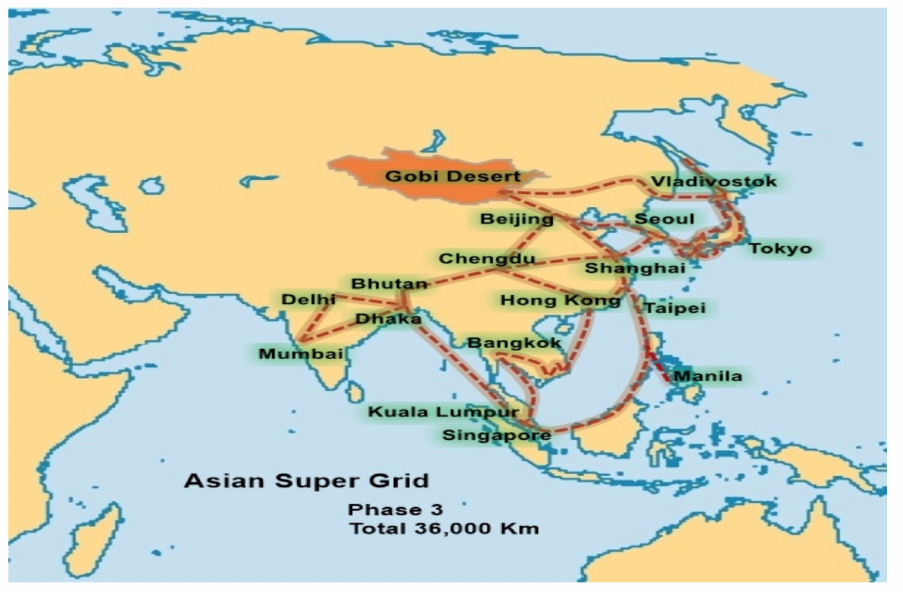
Figure 3. Asia super-grid as planned by State Grid (China), Korea Electric Power, Japan’s Softbank, and Russian power company Rosseti to connect those nations and Mongolia [13]. Asia Super Grid by Jean.julius is licensed under CCBY-SA